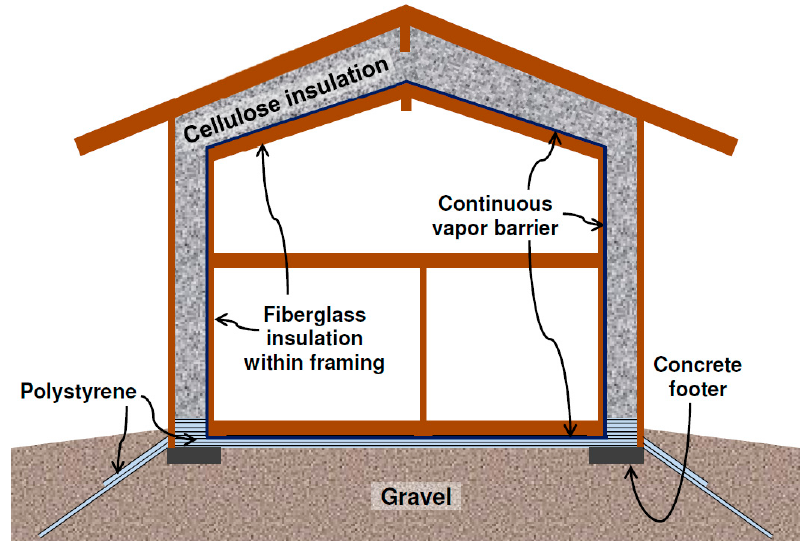
Figure 2. Case Study Home, Dillingham, Alaska.